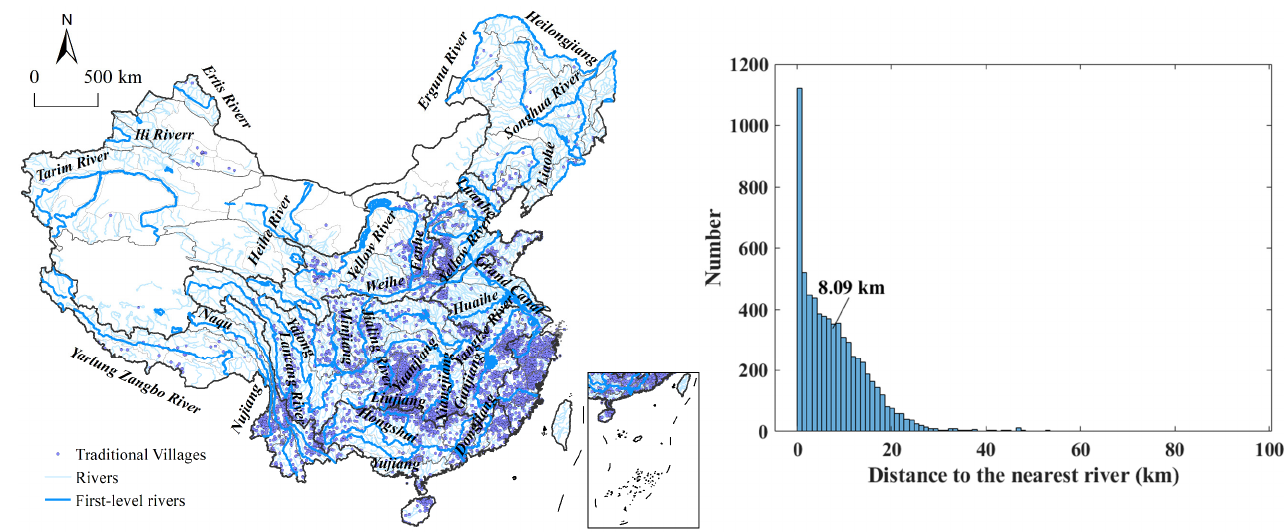
Figure 7. Relationships between traditional villages and rivers in China.